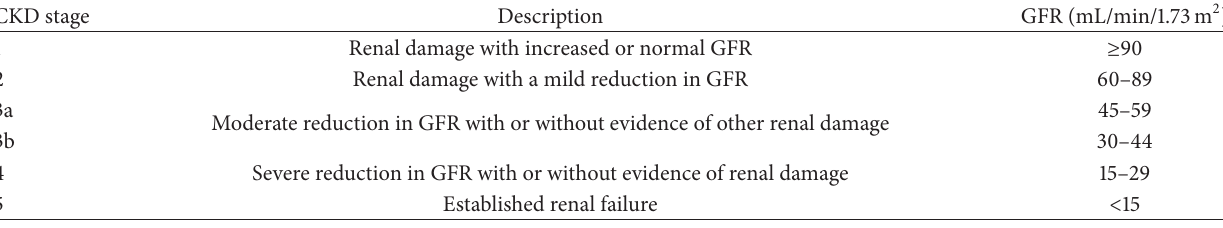
Table 1: Progression of chronic kidney disease